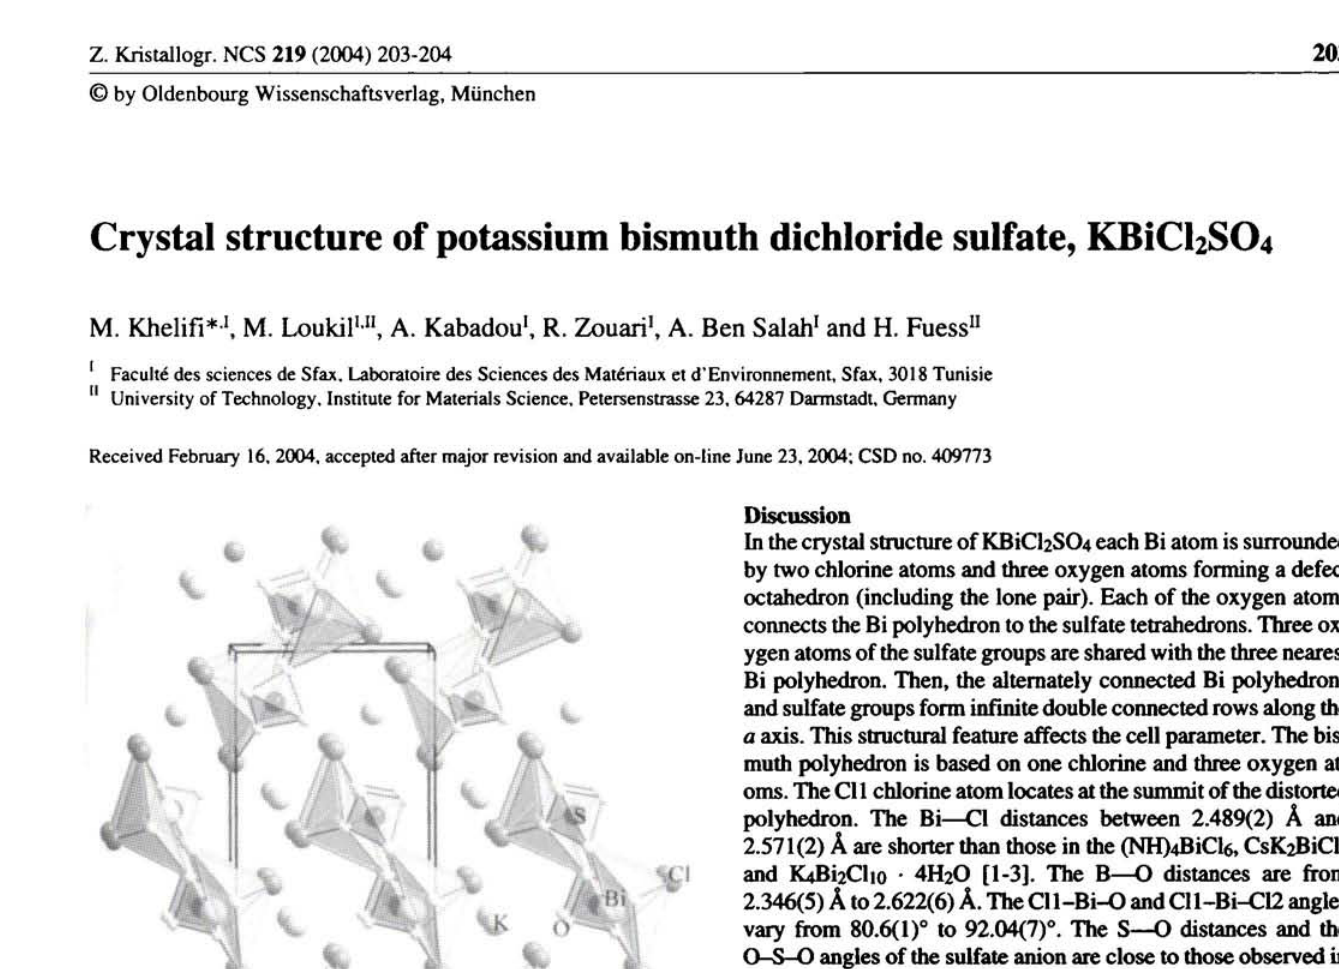
Table 1. Data collection and handling.